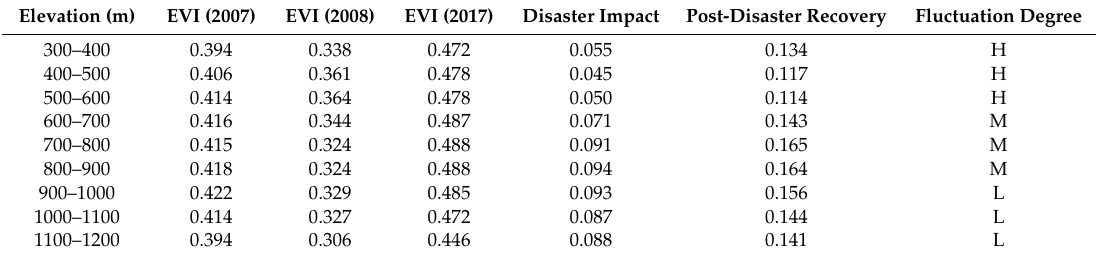
Table 5. Details of the disaster impact and post-disaster recovery in di ff erent elevation zones. In the property row of the table, disaster impact refers to the absolute value of EVI di ff erence between 2008 and 2007; post-disaster recovery refers to the absolute value of EVI di ff erence between 2017 and 2008; fluctuation degree represents the fluctuation of EVI from 2008 to 2017; H, M, and L in fluctuation-degree column represent high, medium, and low, respectively.